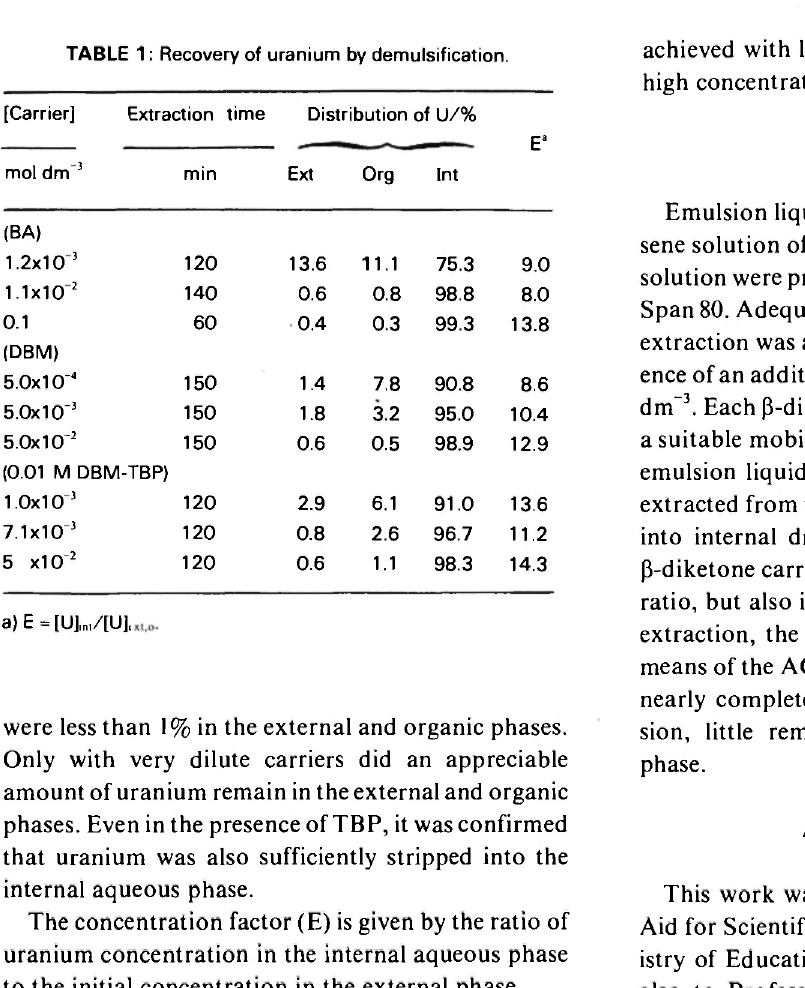
TABLE 1 : Recovery of uranium by